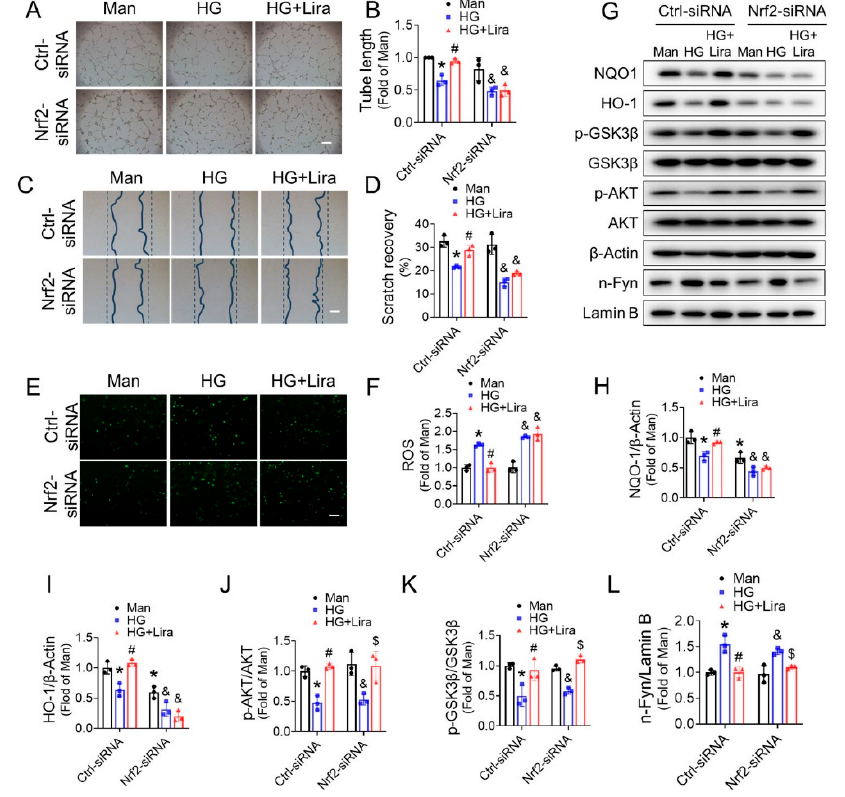
Figure 6. Nrf2 mediates the protective effects of liraglutide against HG-induced EPC dysfunction. The effect of Nrf2-siRNA transfection on the angiogenic function, cell migration and oxidative stress of EPC treated with Man, HG or HG + Lira were investigated by Matrigel tube formation assay ( A , B ), cell scratch assay ( C , D ), and DCF staining ( E , F ), respectively. The effects of Nrf2 knockdown on the expression of NQO-1 ( G , H ), HO-1 ( G , I ), the phosphorylation of AKT ( G , J ), GSK3 β ( G , K ), nuclear content of Fyn ( G , L ) in EPC were determined by western blot and quantified using Imagequant. Three independent experiments were performed for each study. Data shown in graphs represent the mean ± S.D. * p < 0.05 vs. Man group, # p < 0.05 vs. Ctrl-siRNA HG treatment group, & p < 0.05 vs. Nrf2-siRNA + Man group, $ p < 0.05 vs. Nrf2-siRNA + HG group. Bar = 100 µm.